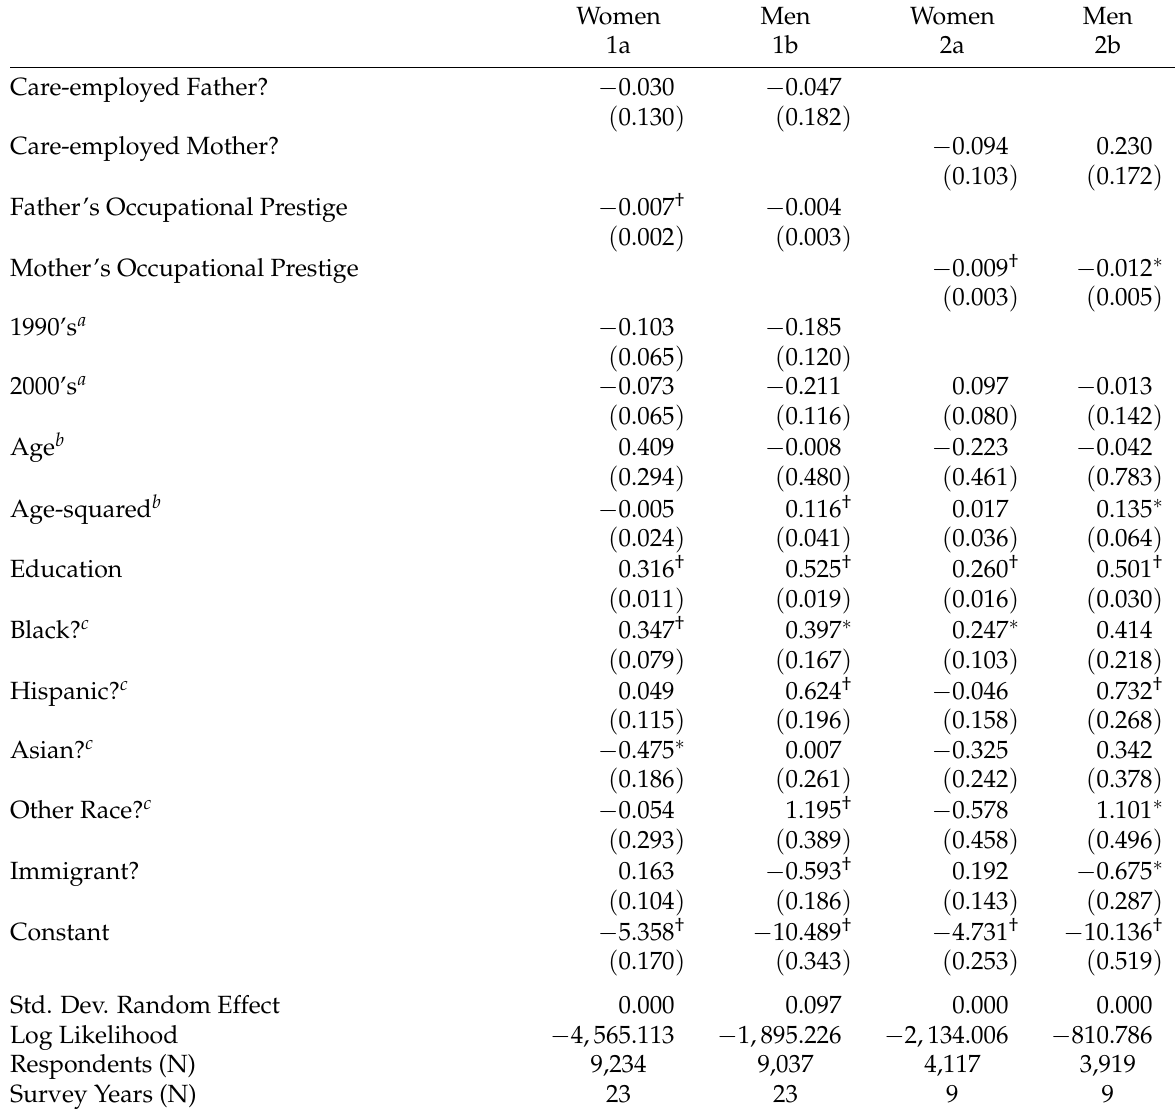
Table 3: Logistic Regression Models Predicting Incumbency in Care Occupations, Excluding Respondents Working in the Parent’s